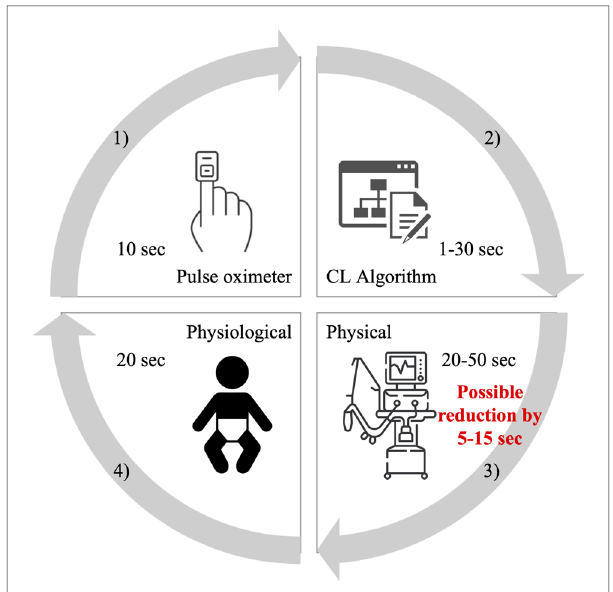
FIGURE 1 Schematic of the delays contained in automatic feedback control systems of oxygenation. These are delays by (1) pulse oximeter averaging, (2) CL algorithm evaluation, (3) physical delays, and (4) physiological processes in the body. The red numbers indicate the expected possibility of reducing the delay in oxygen distribution to the patient caused by technical de fi